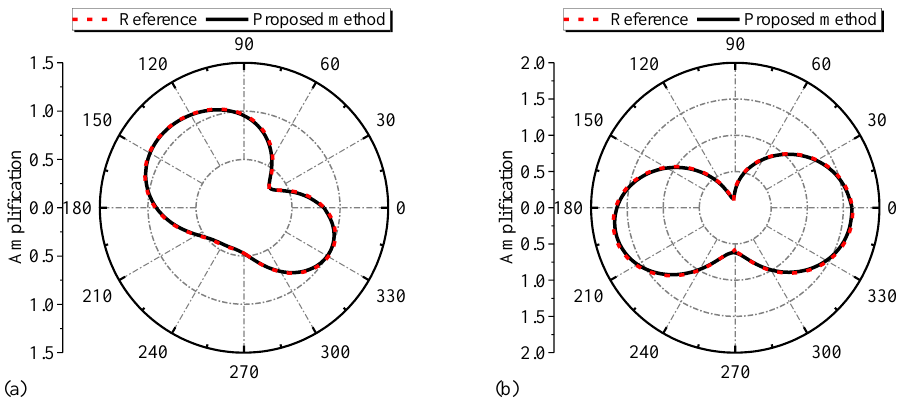
Figure 7. Amplification of radial displacement along the external tunnel surface: ( a ) P wave incident and ( b ) SV wave incident.